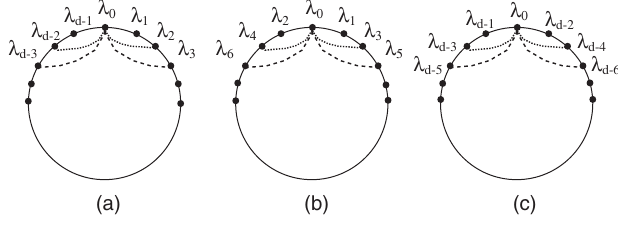
FIG. 8. (a) Weighting factors in Eq. (12) after the feedback has diagonalized and ordered the eigenvalues in (cid:1) . (b) The conjectured general optimal permutation. (c) The conjectured worst permutation. The weights are shown only from the (cid:5)